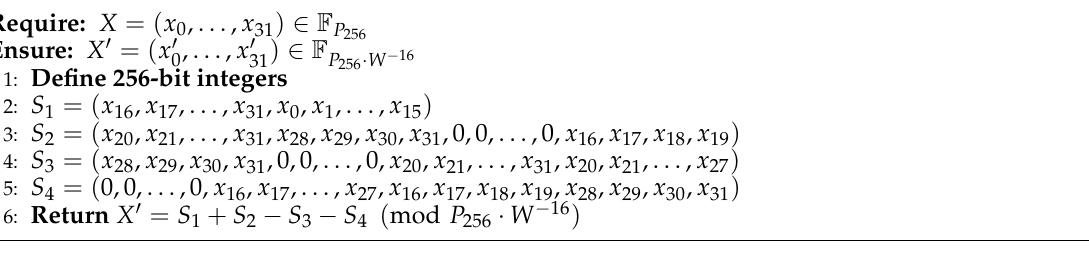
Algorithm 5 Conversion from RSR to original